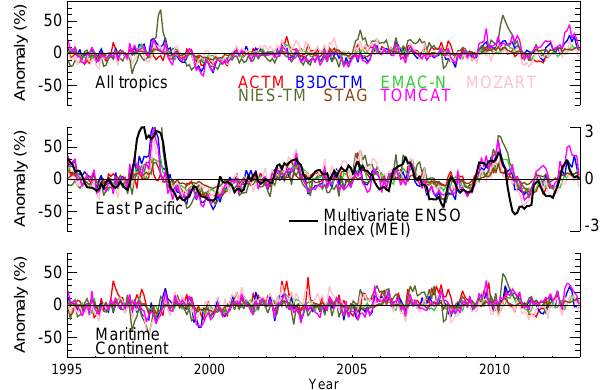
Figure 17. Monthly mean anomalies of CHBr 3 volume mixing ratio at 100hPa, expressed as departures from the climatological monthly mean (%) over (a) tropical latitudes ( ± 20 ◦ ), (b) the tropical eastern Pacific ( ± 20 ◦ latitude, 180–250 ◦ E longitude) and (c) the Maritime Continent ( ± 20 ◦ latitude, 100–150 ◦ E longitude). For the eastern Pacific region, the Multivariate ENSO Index (MEI) is also shown (see text). Note anomalies from free-running models are not